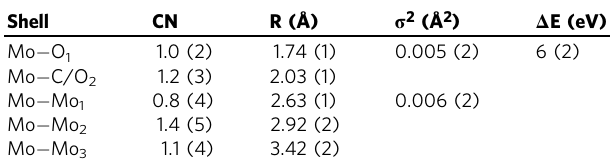
Table 1 EXAFS fi tting of 2D-Mo 2 C T x /SiO 2 (R factor